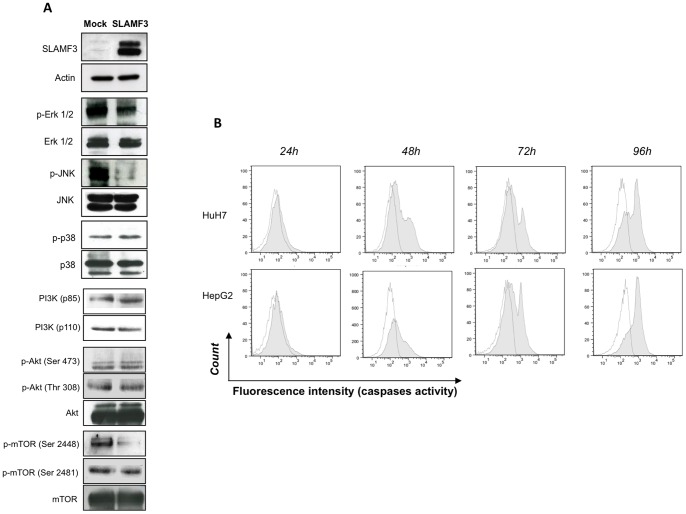
Restoration of SLAMF3 expression in HCC cells inhibits MAPK ERK1/2, JNK and mTOR pathways and induces caspase-dependent apoptosis.(A) SLAMF3 expression was confirmed by Western blot analysis in SLAMF3-over-expressing Huh-7 and mock cells at 48 h post-transfection. ERK1/2, JNK, p38, AKT and mTOR proteins were detected as controls. The activation levels of MAPK ERK1/2 (Thr 202/Tyr 204), JNK (Thr 183/Tyr 185), p38 (Thr 180/Tyr 183), PI3K (p85/p110 Thr 467/Tyr 199), AKT (Ser 473, Thr 308) and mTOR (Ser 2448, Ser 2481) are represented. One of three representative experiments is shown here. (B) The results of an active caspase assay based on cell-permeable fluorochrome inhibitor of caspases (FLICA). Caspase activity was evaluated in HCC cells (Huh-7 and HepG2 lines) at the indicated times after the ectopic introduction of SLAMF3 vector. Caspase activity is shown in the SLAMF3neg subpopulation (in white) and the SLAMF3pos (overlaid in grey) subpopulation from one representative of two independent experiments.